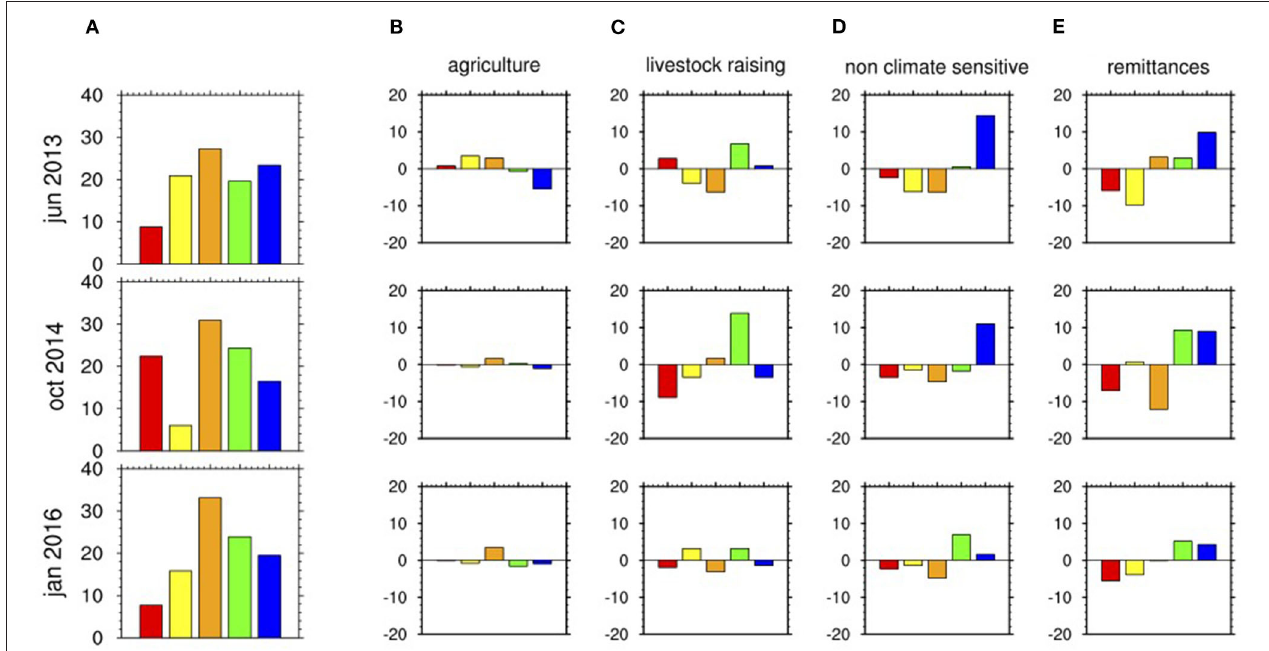
FIGURE 7 | (A) The distribution of rural households into the 5 clusters defined in IN2020, red to blue from least to most food secure, across the three surveys, 2013–2016 from top to bottom. The middle cluster, in orange, is the most common. (B–E) depict variations in cluster membership with respect to the all-household distribution, in (A) , as a function of primary source of income: (B) is for agriculture, (C) is for livestock raising, (D) is for non climate-sensitive activities and (E) is for remittances.